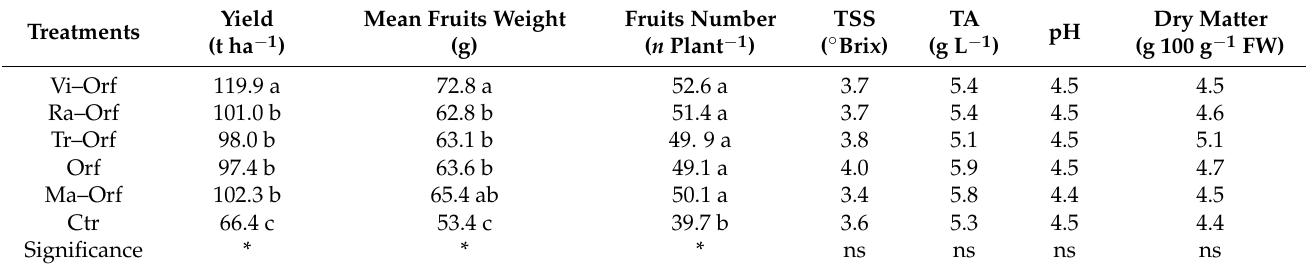
Table 2. Effects of treatments on yield, mean fruits weight, fruits number, total soluble solids (TSS), titratable acidity (TA), pH, and dry